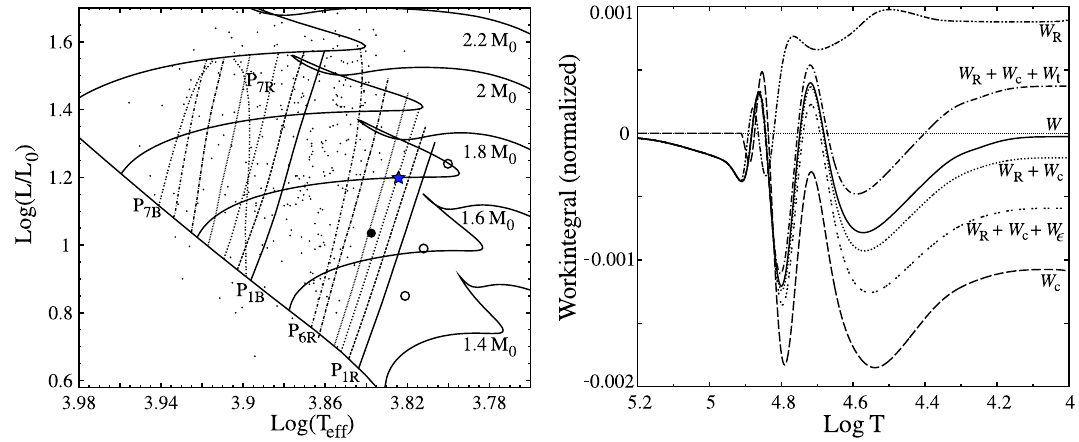
Figure 6: Stability computations of Delta Scuti stars, which include the viscous dissipation rate 𝜖 t of turbulent kinetic energy according to Grigahc`ene et al. (2005). Left: Blue and red edges of the instability strip superposed on evolutionary tracks on the theorists Hertzsprung–Russel diagram. The locations of the edges, labelled p 𝑛 B and p 𝑛 R , are indicated for radial modes with orders 1 ≤ 𝑛 ≤ 7. Results by Houdek (2000, 𝛼 = 2 . 0, see Figure 5) and Xiong and Deng (2001) for the gravest p modes are plotted as filled and open circles respectively. The small dots are observed Delta Scuti Stars (Rodr´ıguez et al. , 2000). Right: Integrated work integral 𝑊 as a function of the depth co-ordinate log( 𝑇 ) for a stable 𝑛 = 3 radial mode of a 1 . 8 𝑀 ⊙ star (see ‘star’ symbol in the left panel). Contributions to 𝑊 arising from the radiative flux, 𝑊 R , the convective flux, 𝑊 c , the turbulent pressure perturbations, 𝑊 t ( 𝑊 R + 𝑊 c + 𝑊 t ), and from the perturbation of the turbulent kinetic energy dissipation, 𝑊 𝜖 ( 𝑊 R + 𝑊 c + 𝑊 𝜖 ), are indicated. Images t t adapted from Dupret et al.